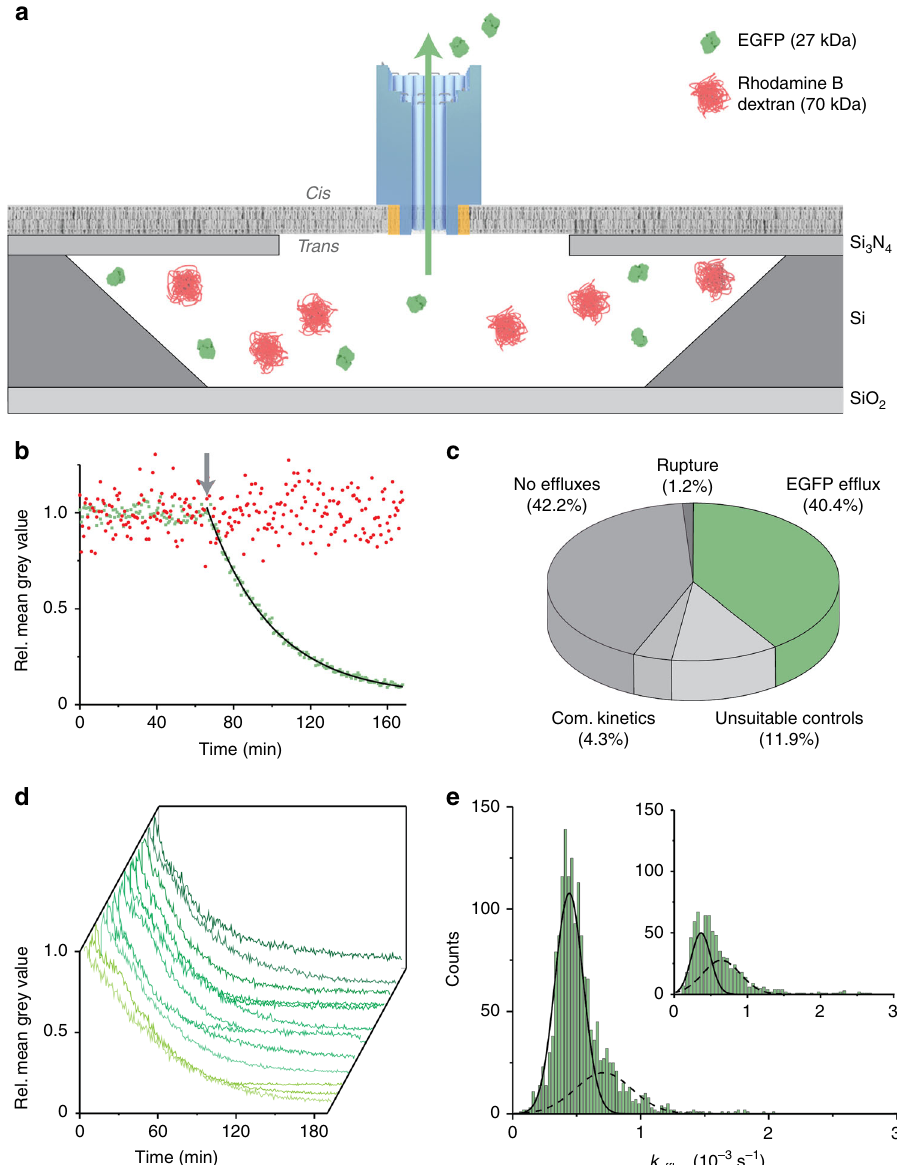
Fig. 5 Kinetic analysis of protein transport through single DNA nanpores analysed using silicon chips. a Architecture of a transparent silicon-on-insulator (SOI) chip featuring a microcavity closed off by a membrane with the embedded DNA nanopore NP. The microcavity contains a solution of enhanced green fl uorescent protein (EGFP) (27 kDa) and Rhodamine B dextran (70 kDa) at the trans side and is separated by the solid-supported lipid bilayer (SLB) from the buffer reservoir ( cis side). EGFP acts as fl ux analyte, whereas larger Rhodamine B dextran (70 kDa) is a negative control for pore transport and indicates membrane rupture. The microcavity is not drawn to scale. b Exemplary normalised EGFP (green squares) and Rhodamine B dextran (red circles) fl uorescence signals implying translocation of folded proteins through a DNA nanopore. The arrow (grey) shows the point of spontaneous membrane insertion of a nanopore. c The statistics of thousands of single translocation traces are classi fi ed in nanopore-mediated EGFP ef fl uxes, membrane ruptures, complex kinetics, and inadequate controls as well as cavities without signal changes. The statistics were obtained for 1 pM NP. d Multiple similar, normalised EGFP ef fl ux traces from different SOI cavities indicate high structural homogeneity among nanopores. e DNA pore-mediated ef fl ux traces were fi tted monoexponentially with rate constant k ef fl ux and the values are summarised in the histograms. The distribution of ef fl ux constants was Gaussian fi tted to reveal single nanopore ef fl ux constants ( k eff single ) (solid line) and double nanopore ef fl ux constants ( k ef fl ux double ) (dashed line). The proportion of single nanopore ef fl ux constants was larger for 1 pM DNA nanopore NP compared to 10 pM (inset). The total number of individual traces in the histograms are 1649 and 737, respectively. Source data are provided as a Source Data fi EGFP. The antibody (137 kDa) was added to the chip cavities in effectively inhibited pore translocation as only 0.7% of cavities slight excess over His6 EGFP to form a large biomolecular complex displayed His6 EGFP ef fl uxes (Fig. 6c), in comparison to the and impede pore-mediated ef fl ux of the fl uorescent protein EGFP-mediated ef fl uxes of 40.4% without α -His antibodies (Fig. 6a). Indeed, analysis of hundreds of cavities revealed that (Fig. 5c). Complex kinetics of His6 EGFP ef fl ux were at 2.4% and unsuitable controls of Rhodamine B dextran at 9.9% (Fig. 6c). 71.8% featured unchanged green fl uorescence (Fig. 6b, c) even Membrane ruptures accounted for 15.2% of cavities, which is though a high pore concentration of 1.1 nM was used. Antibodies